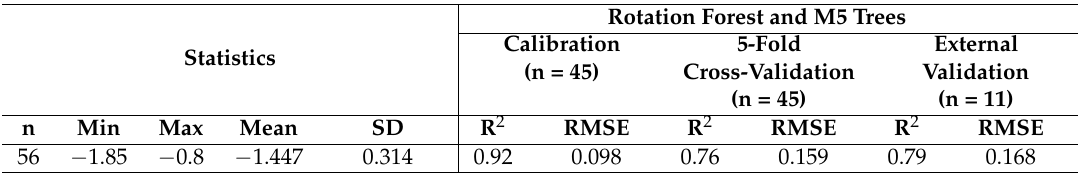
Table 7. Statistic overview and results of the ψ stem (MPa) estimation for the variety-specific model (Tempranillo) using a rotation forest and M5